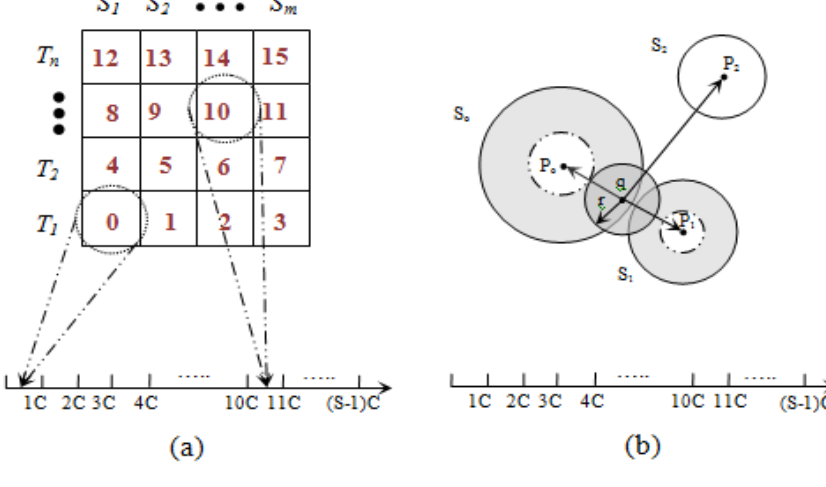
Figure 2. ( a ) Data mapping; and ( b ) range query